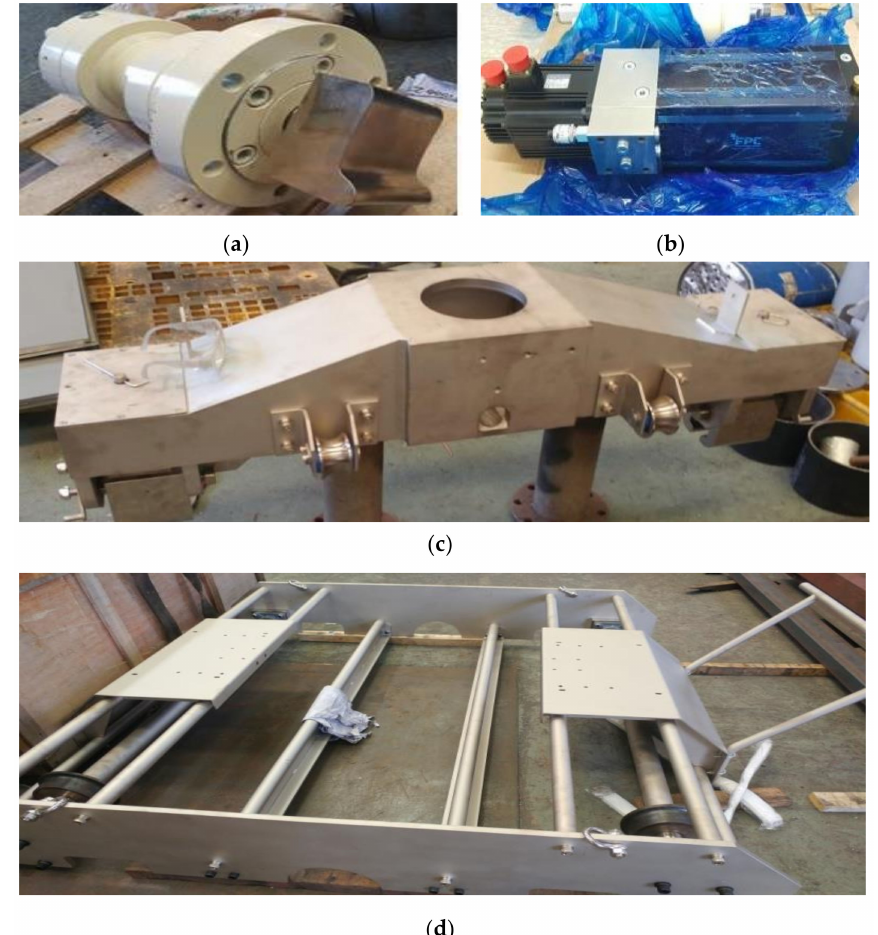
Figure 14. Photograph of TSS tester components. ( a ) Actuator and wheel jig; ( b ) Hydraulic motor; ( c ) Body frame; ( d ) Bogie